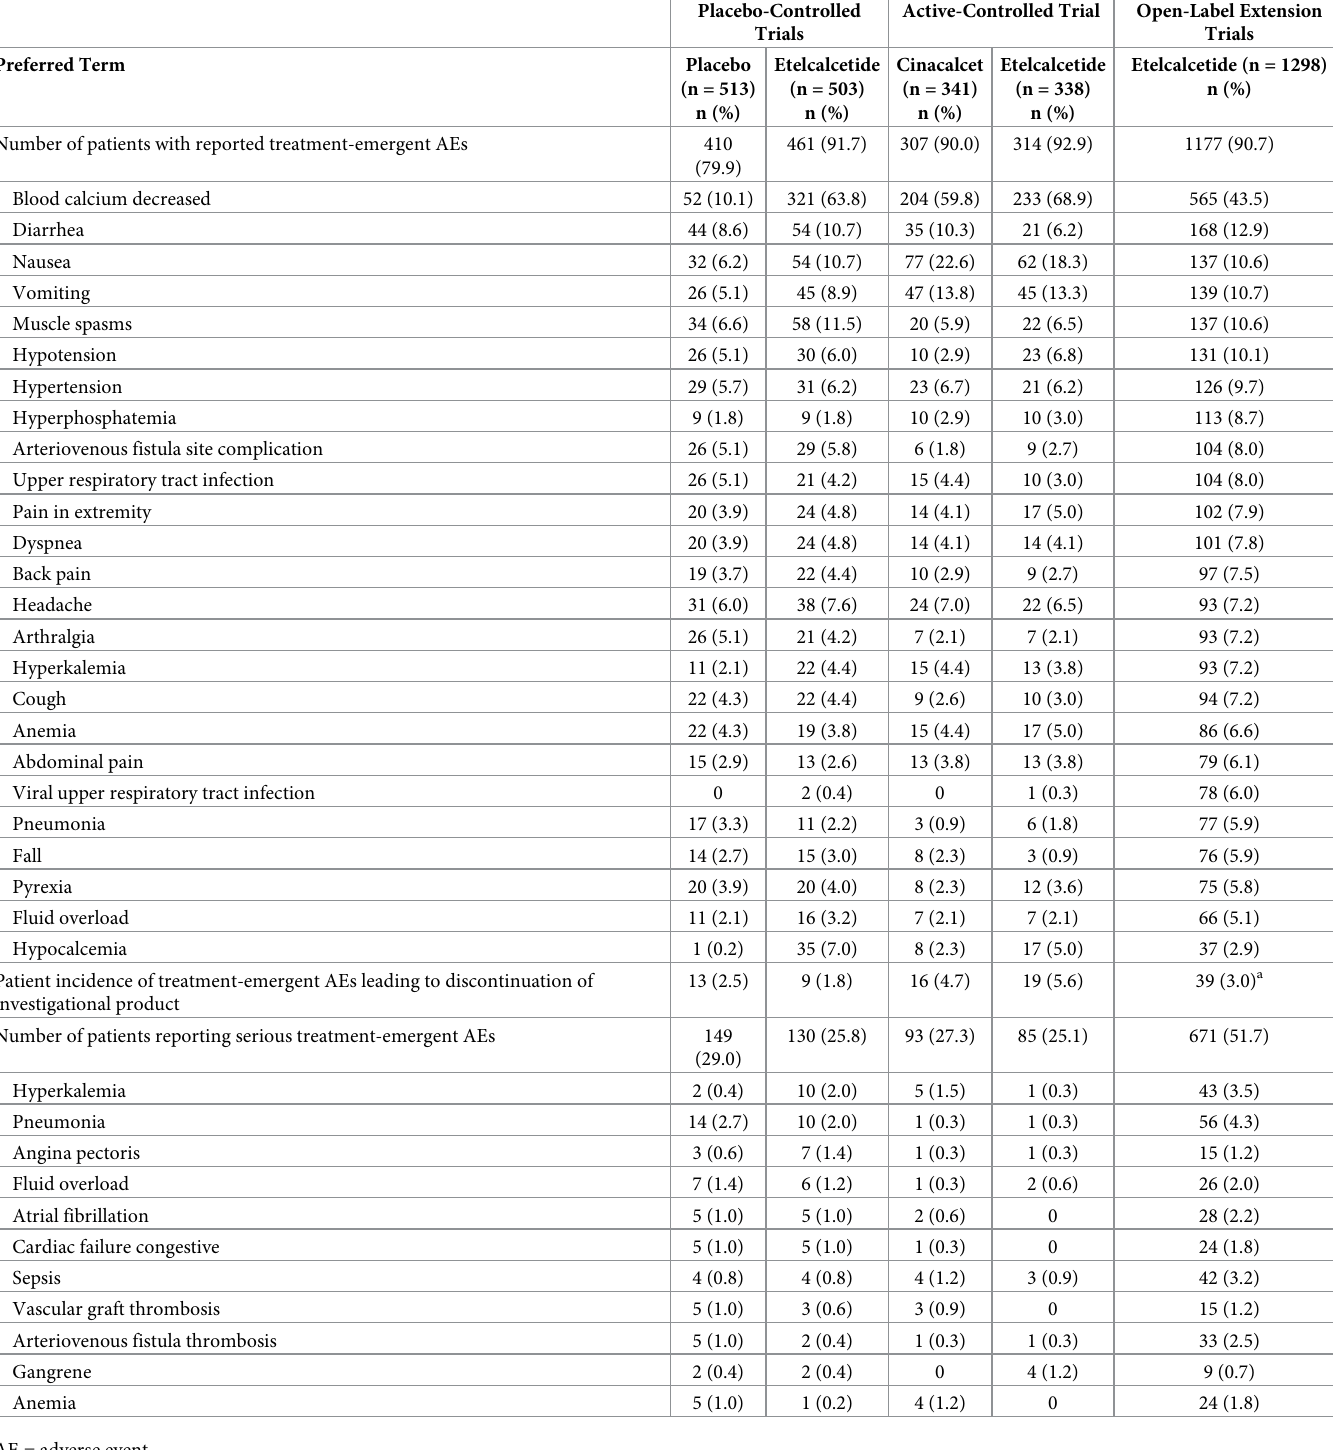
Table 2. Treatment-emergent adverse events occurring in � 5% of patients in the etelcalcetide arms, adverse events leading to discontinuation, and serious adverse events.